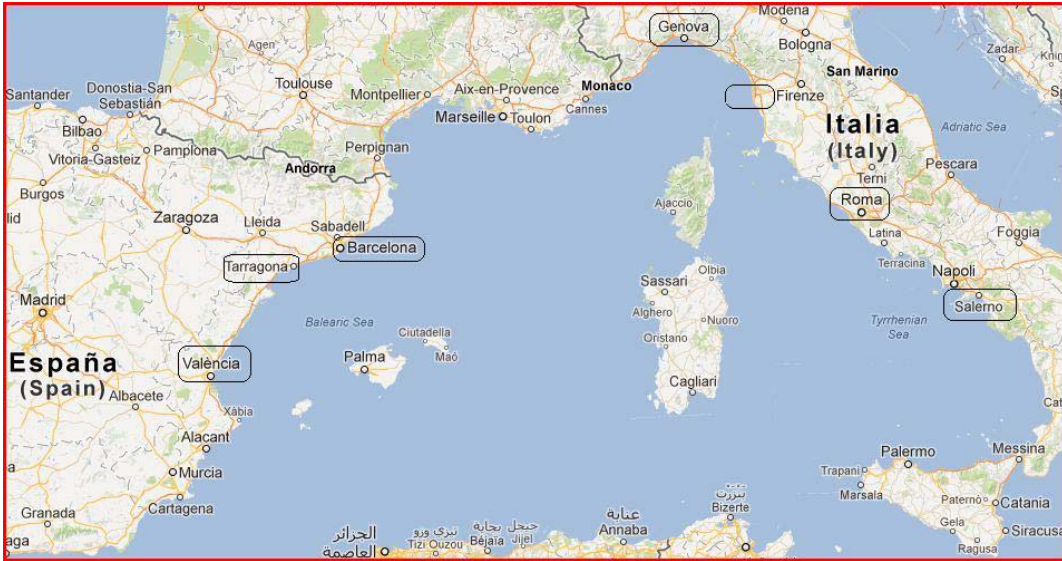
Figure 2. Locations of the cities that constitute the ends of the sea links